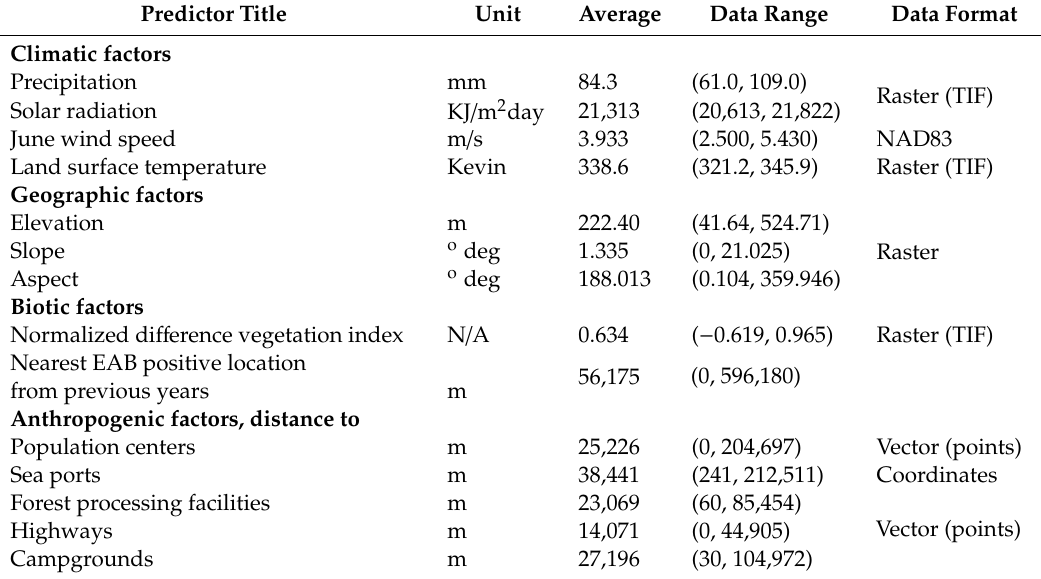
Table 2. The fourteen risk predictors